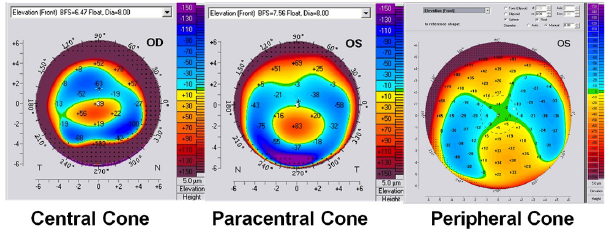
Figure 4. Classification of cone location on the anterior elevation map with the BFS float mode. The cone is central when its apex is within the 3 mm central circle, paracentral when it is in between 3 and 5 mm central circles, and peripheral when it is out of the 5 mm central circle.